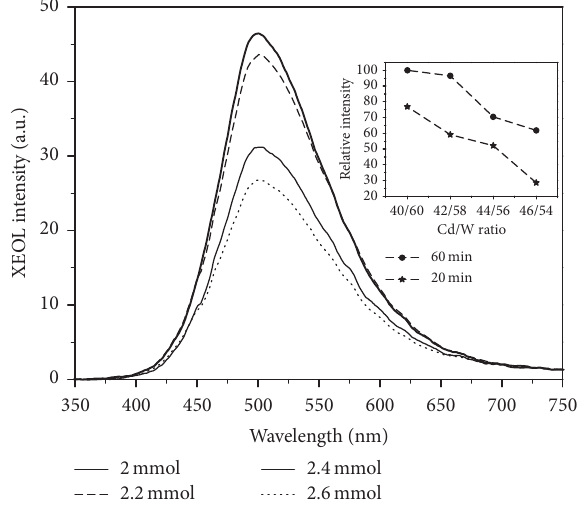
Figure5:XEOLemissionspectraofsamplespreparedwithdifferent cadmium precursor (CdO) amounts and reaction time of 60 min. The inset shows the total light output, for reaction times of 20 min and 60 min, obtained from the area under the luminescence curves, as function of Cd/W atomic ratio, as determined by